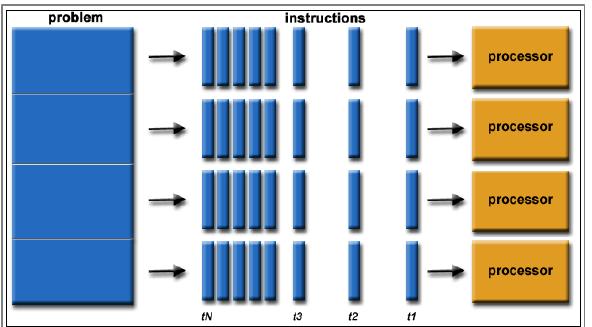
Figure 1 . General parallel processing architecture in a single machine (Source: OmniSci).